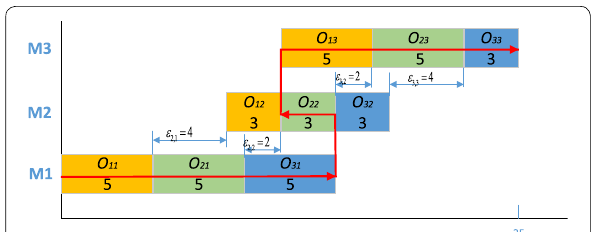
Figure 7 The maximum processing time of the operation could be added in the Gantt chart